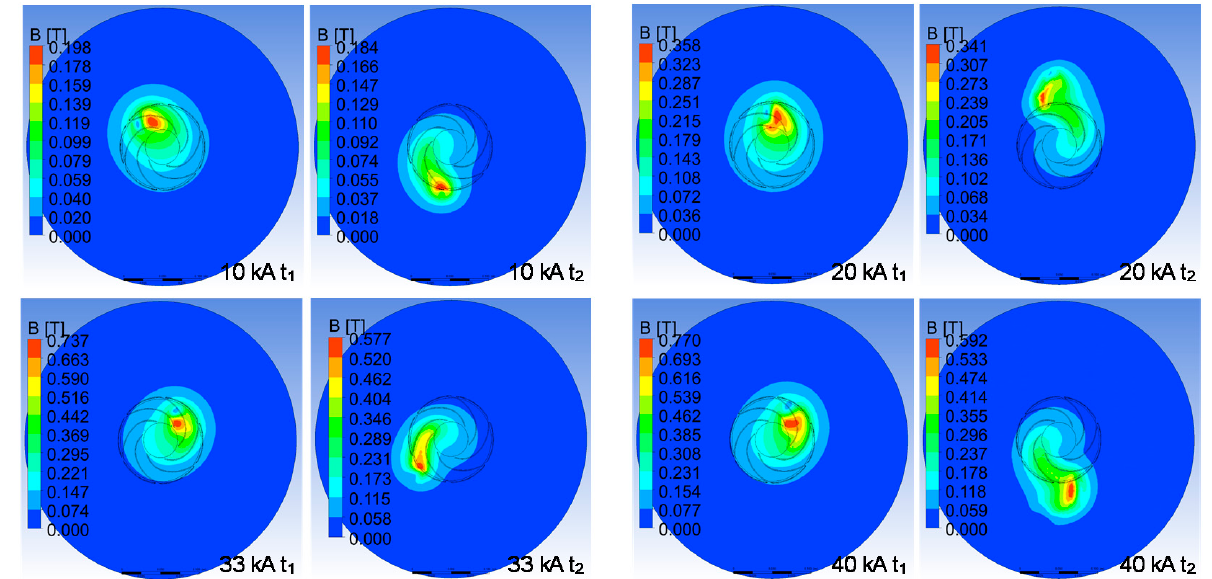
Figure 10. A comparison of the magnetic flux density under different current levels with a range between 10 kA and 40 kA. t 1 and t 2 respectively represents the time of peak current and 28 μs .